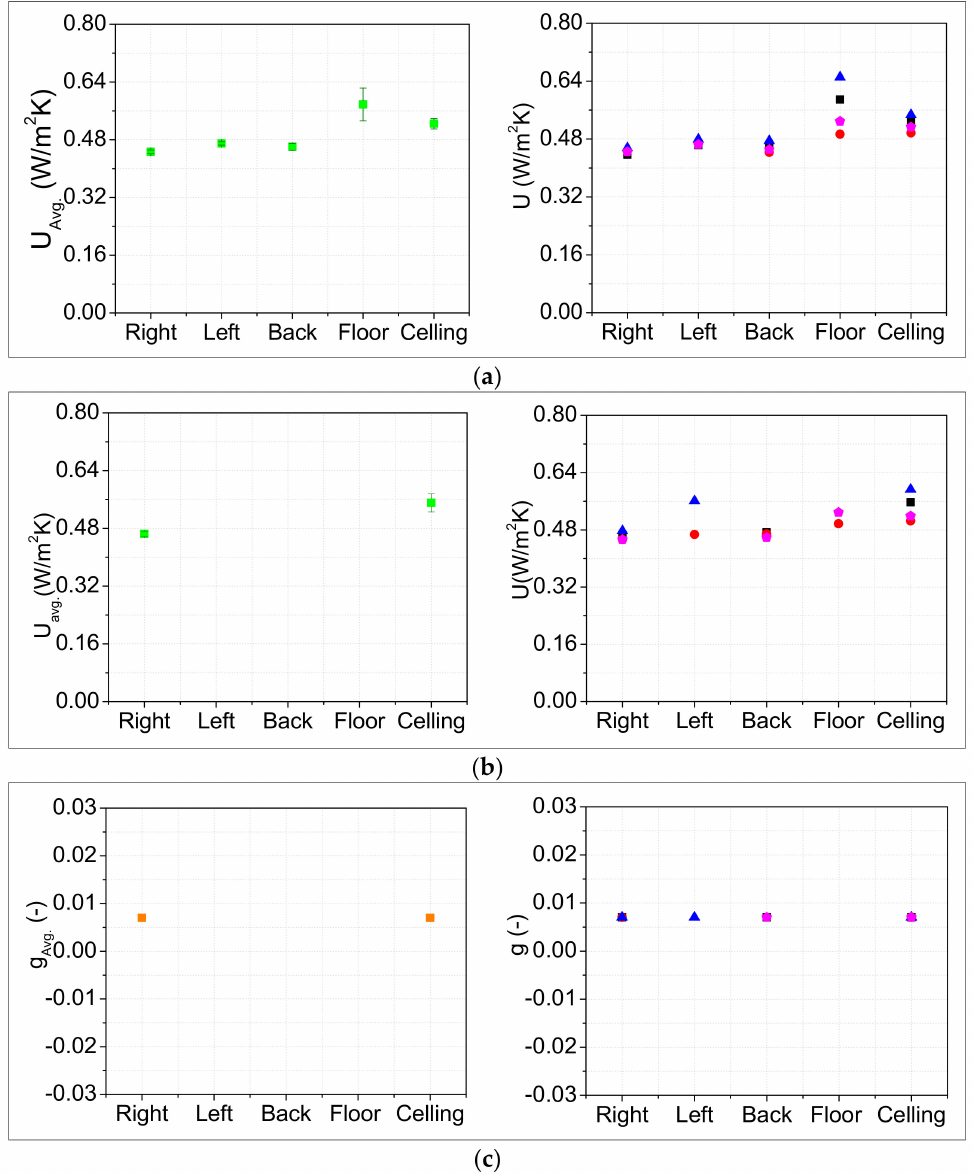
Figure 5. All the opaque walls: results obtained using a four nodes model. Left: average of U value for series a, b and c. Right: values for series a in black, series b in red, series c in blue and pink for the full data series d. ( a ) Not including solar radiation. Output: T i ; ( b ) including solar radiation. Output: T i ; ( c ) including solar radiation. Output: T i